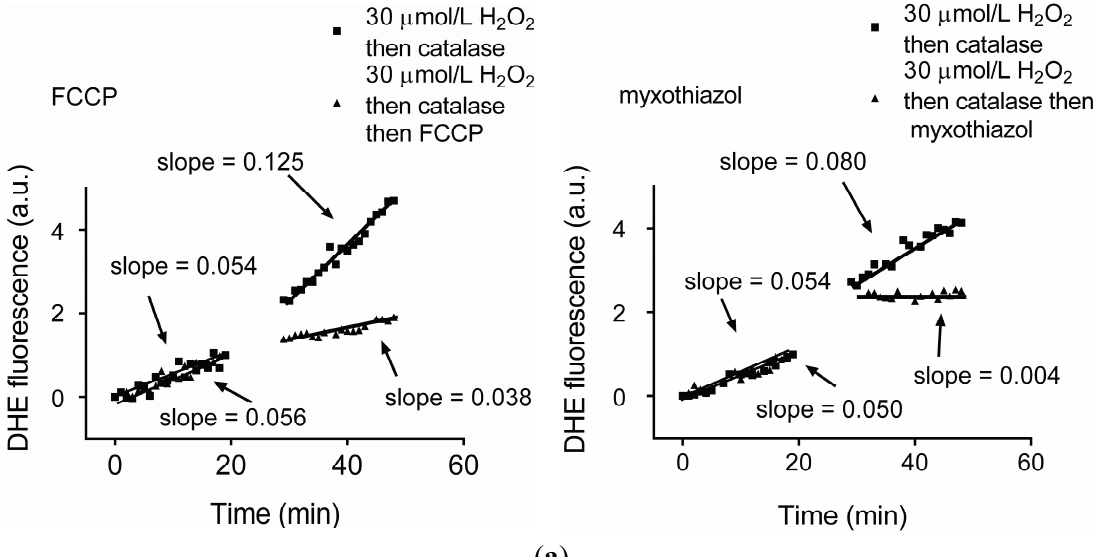
Figure 1. Transient exposure to H 2 O 2 leads to L-type Ca 2+ channel-dependent increase in mitochondrial superoxide, triggering ROS-induced-ROS release. ( a ) dihydroethidium (DHE) fluorescence recorded from individual guinea pig cardiomyocytes before and after exposure to 30 µM H 2 O 2 for 5 min followed by 10 U/mL catalase for 5 min then 2 nM FCCP (an uncoupler of oxidative phosphorylation) as indicated ( left panel ) or 7 nM myxothiazol (to block electron transport at mitochondrial complex III) ( right panel ); ( b ) DHE fluorescence recorded from individual guinea pig cardiomyocytes before and after exposure to 30 µM H 2 O 2 for 5 min followed by 10 U/mL catalase for 5 min and the L-type Ca 2+ channel antagonist nisoldipine (nisol; 2 µM) as indicated ( left panel ) or ryanodine receptor antagonist dantrolene (20 µM; right panel ); and ( c ) Schematic illustrating the persistent increase in intracellular ROS and intracellular Ca 2+ following a transient H 2 O 2 exposure or ROS-induced ROS-release. Reproduced with permission from